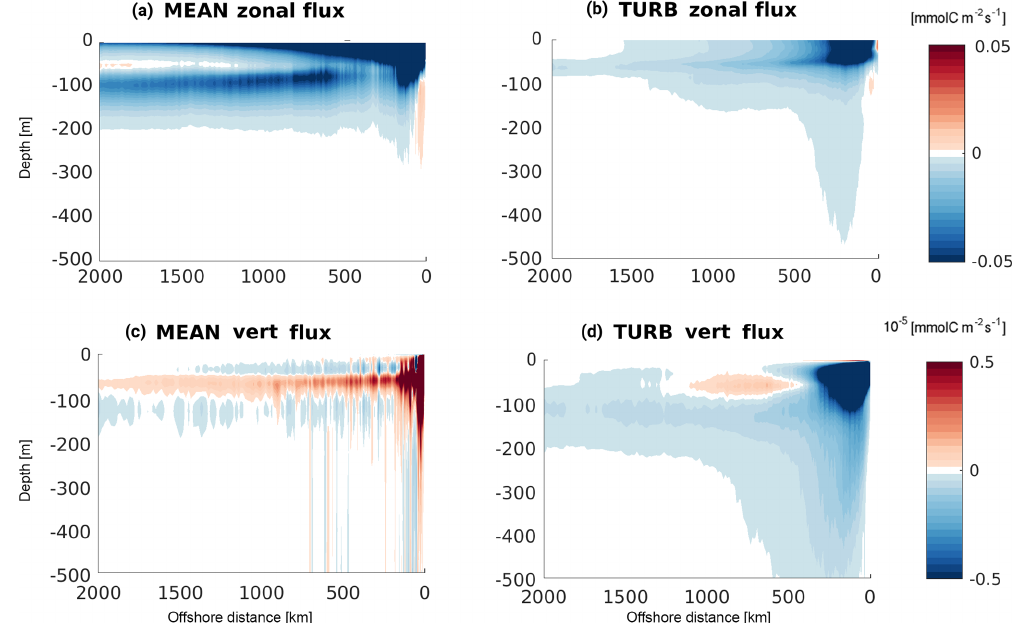
Figure 7. Reynolds mean and turbulent components of the advective fluxes of C org averaged along lines of equal distance from the coast in the whole CanUS. (a) Mean zonal advective flux; (b) turbulent zonal advective flux; (c) mean vertical advective flux; (d) turbulent vertical advective flux.